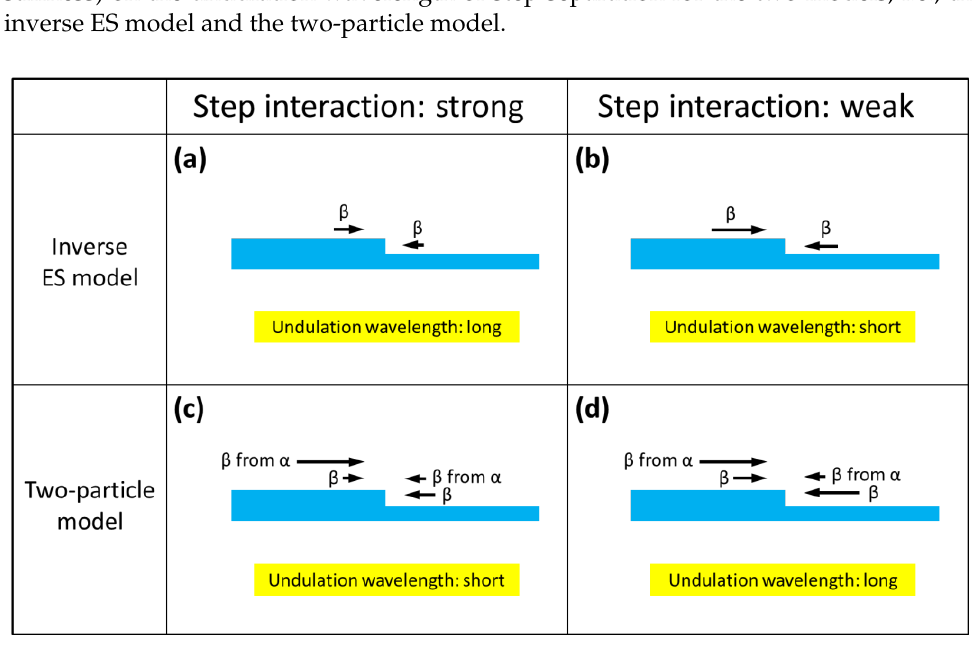
Figure 6. Schematic figures illustrating the effect of the step repulsive interaction on the undulation wavelength of step separation for the inverse ES model and the two-particle model. In the figure, the direction and magnitude of the adatom flows toward the steps on a vicinal crystal surface are indicated by the black arrows, and in each section of the figure, the influence of the step repulsive interaction on the adatom flows is schematically illustrated; the adatom flows toward the steps, which express the amount of adatoms incorporated into the steps from the upper and lower terraces, are reduced by the step repulsive interaction. ( a ) the inverse ES model with a strong step repulsive interaction, ( b ) the inverse ES model with a weak step repulsive interaction, ( c ) the two-particle model with a strong step repulsive interaction, and ( d ) the two-particle model with a weak step repulsive interaction.